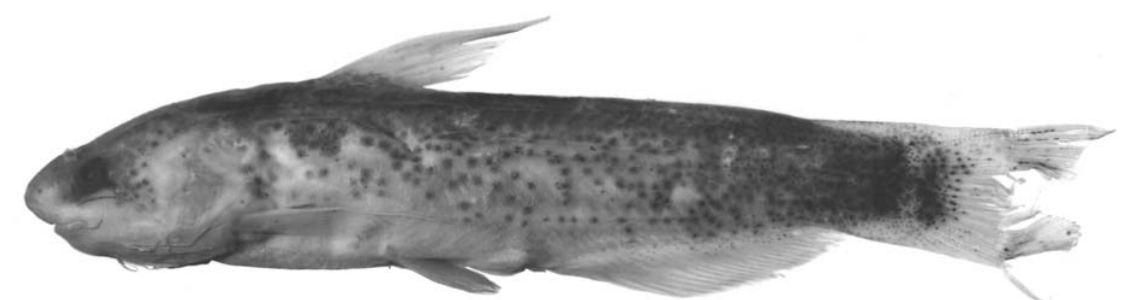
Fig. 44. Cetopsis umbrosa , new species, holotype, ANSP 137559, 54 mm SL; Colombia, Meta, río Negro, downstream from main Villavicencio-Puerto Lopez highway at La Balsa (04°04’N,